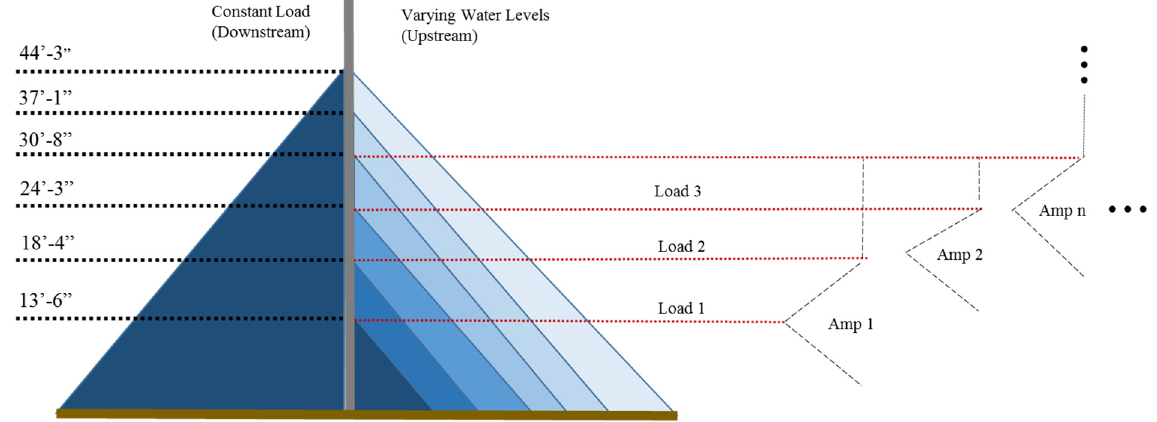
Figure 5. Different hydrostatic load levels applied on the gate (ft.—in.) and simulation of water level elevation change through hydrostatic load amplitude triggering.